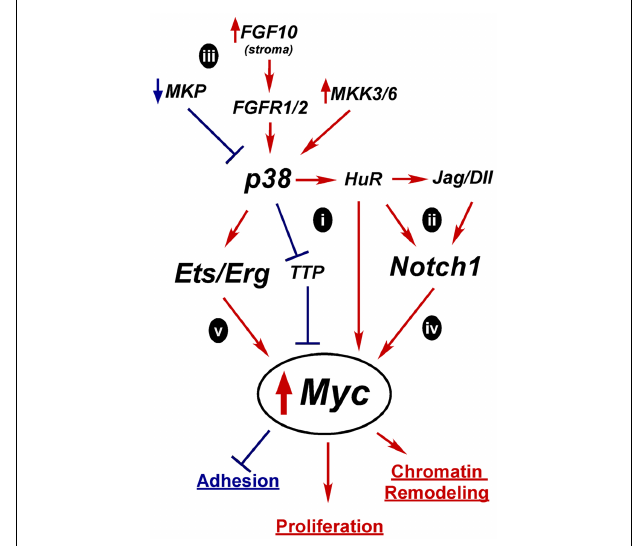
FIGURE 4 | Hypothetical mechanisms for Myc upregulation in prostate oncogenesis . A tightly controlled increase in Myc expression is required for differentiation, but prolonged and excessive Myc activity is oncogenic and leads to increased proliferation, altered adhesion, and chromatin remodeling. Constitutive activation of p38 and Notch1 are two possible alternative mechanisms for upregulating Myc expression early in tumorigenesis. Active p38 can regulate mRNA stability proteins, such as TTP and HuR which affect Myc, Notch1, or Notch ligand mRNA half-life (i,ii) . Overactive p38 signaling could result from loss of MAPK phosphatases (MKP), alternate growth factor receptor expression, or activation of MKKs (iii) . Independently, overexpressed Notch ligands could stimulate Notch1 leading to increased Myc transcription (iv) . Activation of p38 may enhance Erg/Ets fusion gene activity to drive Myc overexpression (v)